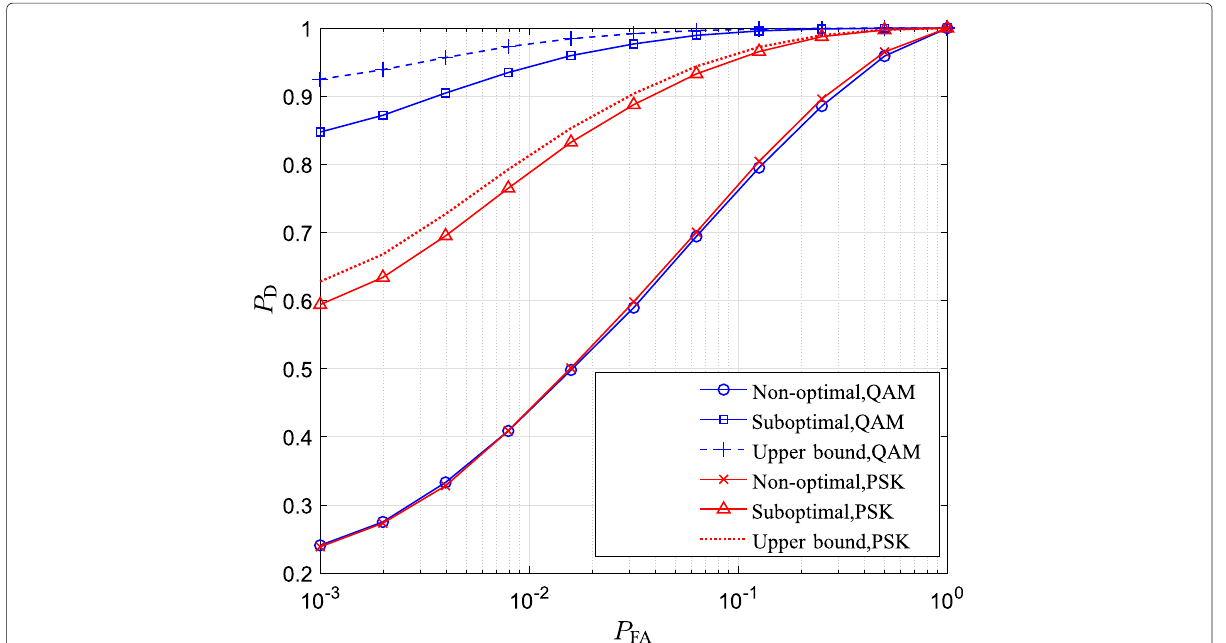
Fig. 8 Detection probabilities comparison between suboptimal and non-optimal signal design and the corresponding upper bounds. The two compared relays have (α rx , θ rx , α tx , θ tx ) = ( − 0.03,3 ◦ ,0.03,3 ◦ ) , (α rx , θ rx , α tx , θ tx ) = ( 0.02,5 ◦ , − 0.05, − 4 ◦ ) , SNR = 16 dB, N =